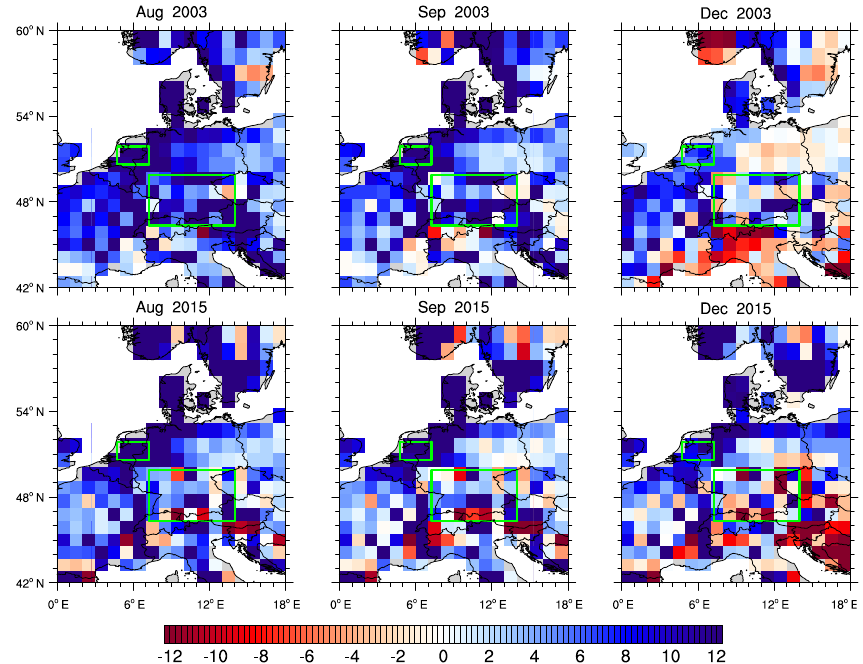
Figure A1. Groundwater anomalies (cm) based on GRACE and VIC model outputs for the available 3 common months (August, September, and December) during the 2003 and 2015 drought events (top panels), estimated by removing the total surface water storage anomaly (TOW, which is the combination of soil moisture, canopy storage, and snow water equivalent) from the GRACE-TWS anomaly (Fig.